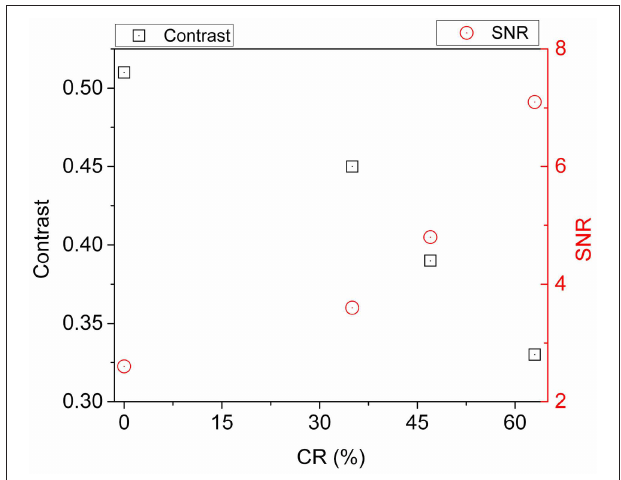
FIGURE 7 | Variation of image quality indicator according to the compaction ratio of scanned